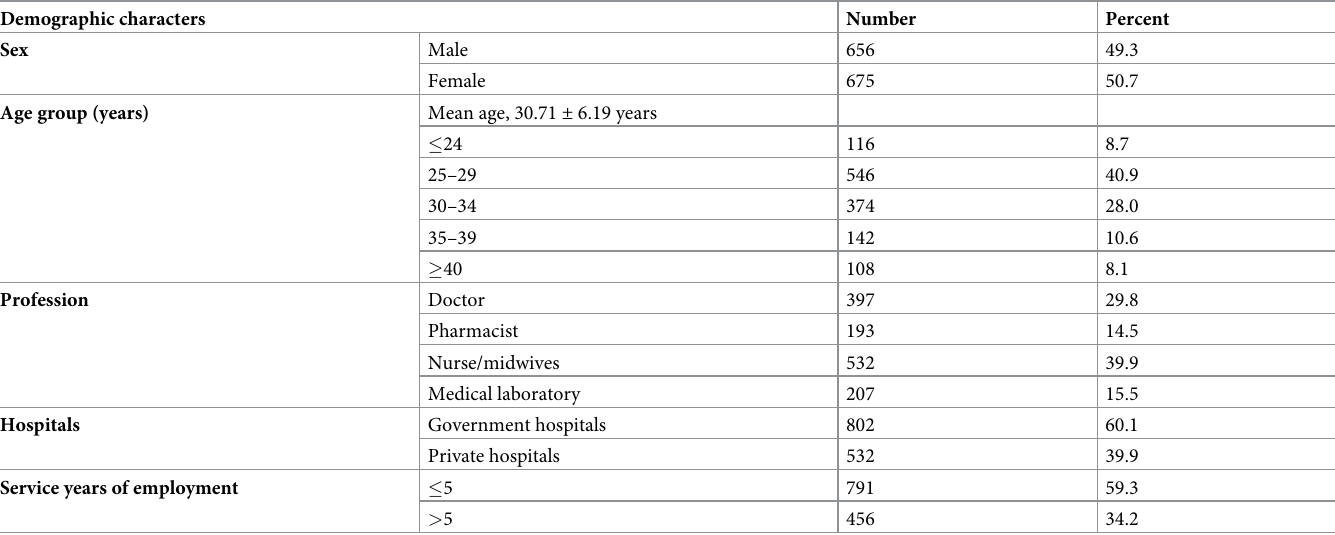
Table 1. Demographic characteristics of health